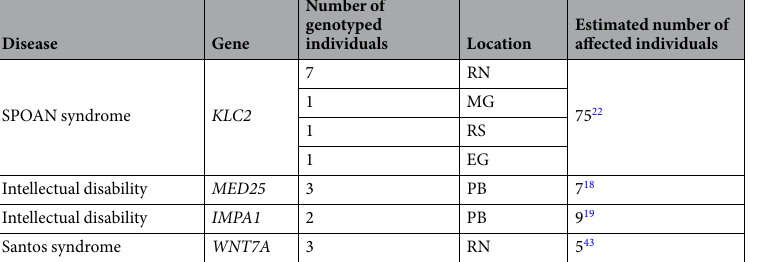
Table 3. AR-affected individuals with genetic